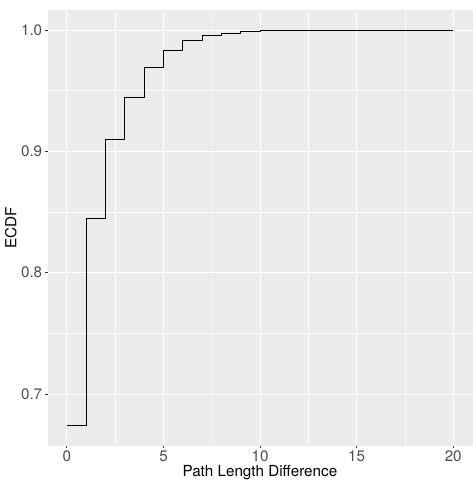
Figure 7: Path length differences between PPP and